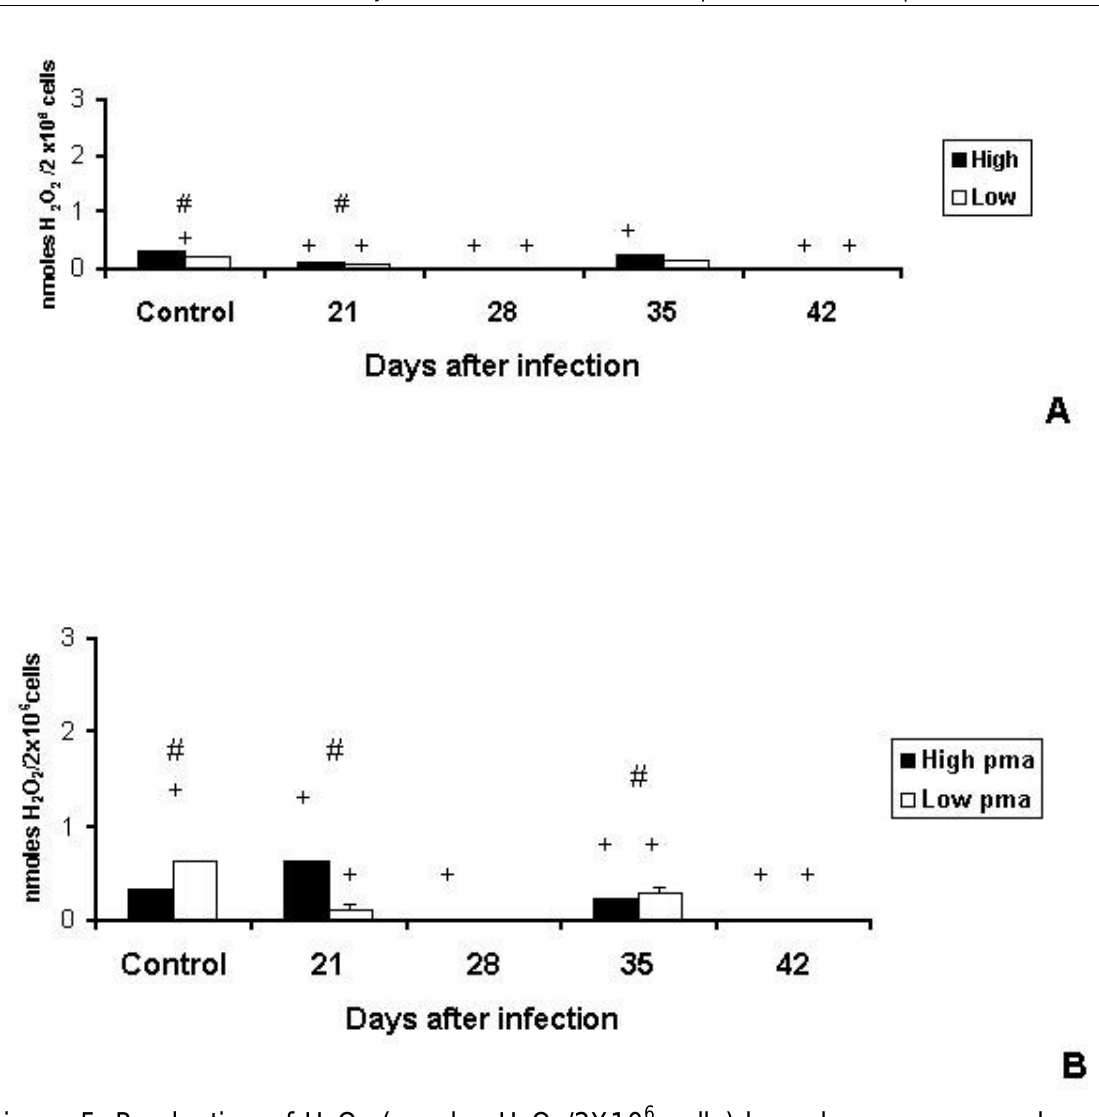
Figure 5. Production of H of High and Low antibody producer (Selection IV-A) mice infected with Mycobacterium bovis -AN controls. (A) Endogenous production of H Low mice. (B) Endogenous production of H Low mice subjected to additional phorbol myristate acetate (pma) stimulus. #: interline difference +: difference between infected animals and their respective